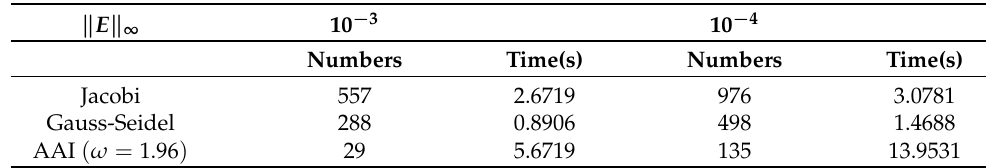
E Figure 6. The ∞ with the different ω and the errors at z = 0.5 when l = m = s = 31, h = 1/30, n = 150. (cid:107) (cid:107) E ( a ) The errors ∞ with the different ω ; ( b ) The errors at z = 0.5 when ω = 1.76. (cid:107) (cid:107) Table 6. The iteration numbers and time(s) of Jacobi, Gauss-Seidel and the AAI algorithm under the different error controls when l = m = s = 31, h = 1/30.